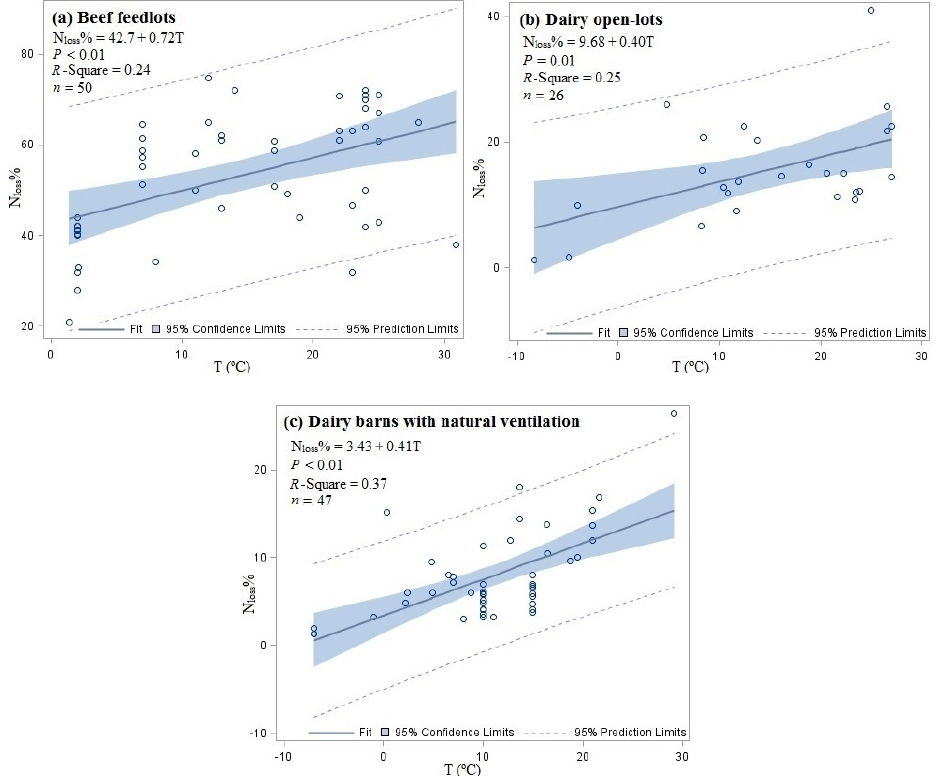
Figure 3. Fit plots for NH 3 -N loss as a percentage of N intake (N loss %) as a function of air temperature (T) for: ( a ) beef feedlots; ( b ) dairy open ‐ lots; and ( c ) dairy barns with natural ventilation.